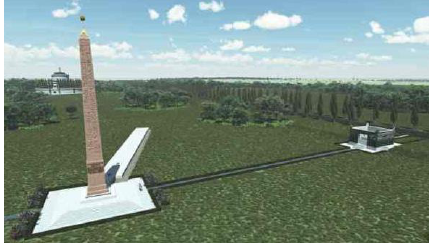
Figure 17: Auber, Obelisk of the Solarium with Ara Pacis and Mausoleum Augusti